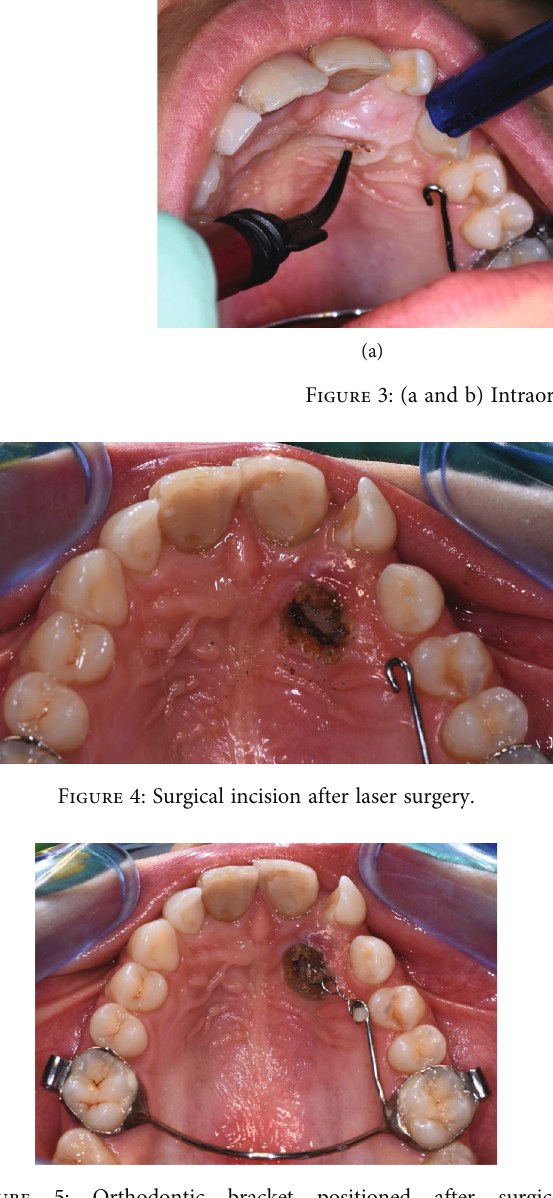
Figure 5: Orthodontic bracket positioned after surgical operculectomy, with a passive metal looped ligature and secured with composite.